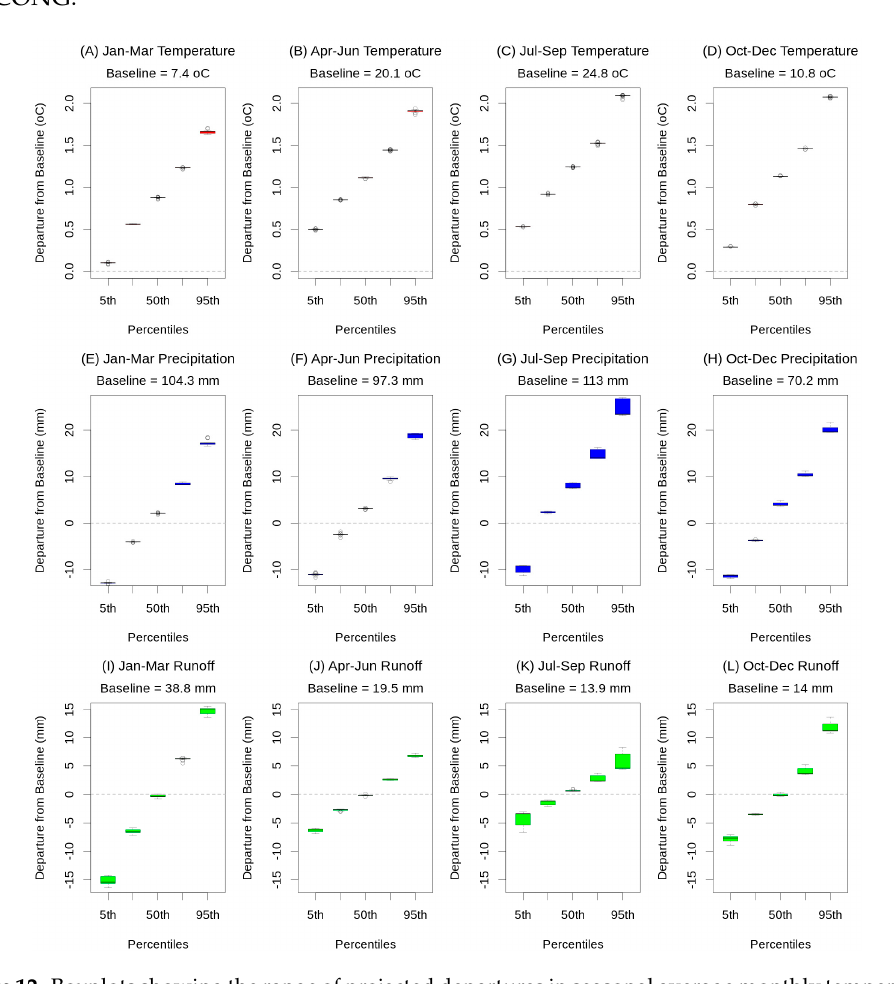
Figure 12. Boxplots showing the range of projected departures in seasonal average monthly temperature in degrees Celsius (°C), precipitation in millimeters (mm), and runoff (in mm) projected for 2030 for each HRU in Congaree National Park (CONG) by percentiles (5th, 25th, 50th, 75th, and 95th) from 214 climate simulations HRU, Hydrologic response unit; Jan–Mar, January–March; Apr–Jun, April–June; Jul–Sep, July–September; Oct–Dec, October–December. See Figure 9 caption for a full description of box and whisker statistics.